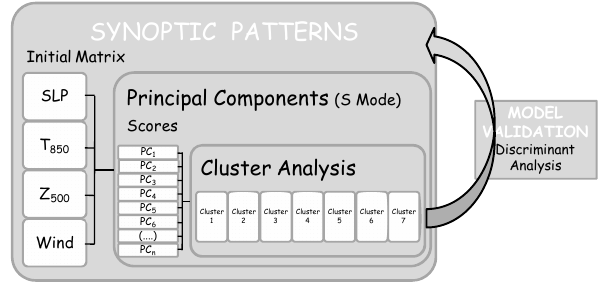
Fig. 3: Diagram of the methodology used. 574 Fig. 3. Diagram of the methodology